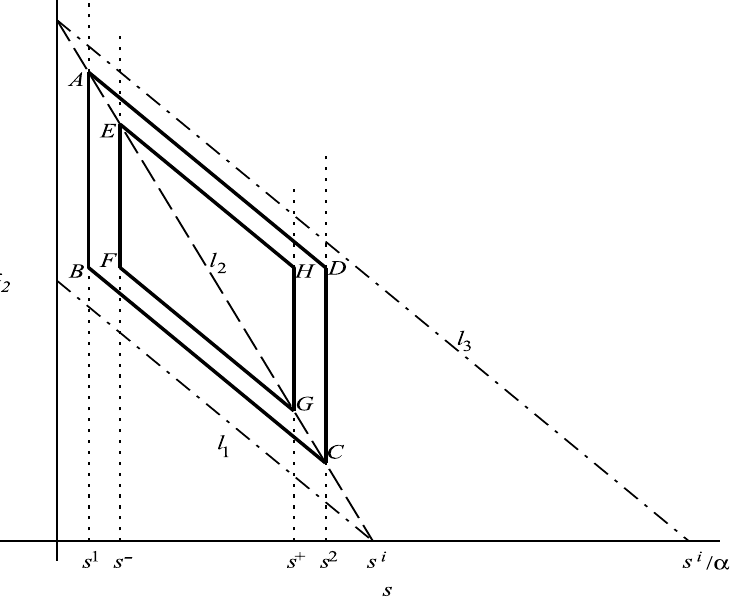
Fig. 1. The parallelogram L ( s 1 , s 2 ) = ABCD , A = ( s 1 , x 1 2 ) , B = ( s 1 , ˜ x 1 2 ) , C = ( s 2 , x 2 2 ) , D = ( s 2 , ˜ x 2 2 ) ; the parallelogram L ( s − , s + ) = EFGH , E = ( s − , x − l 2 : s + αk 3 x 2 = s i , l 3 : s + k 3 x 2 = s i /α